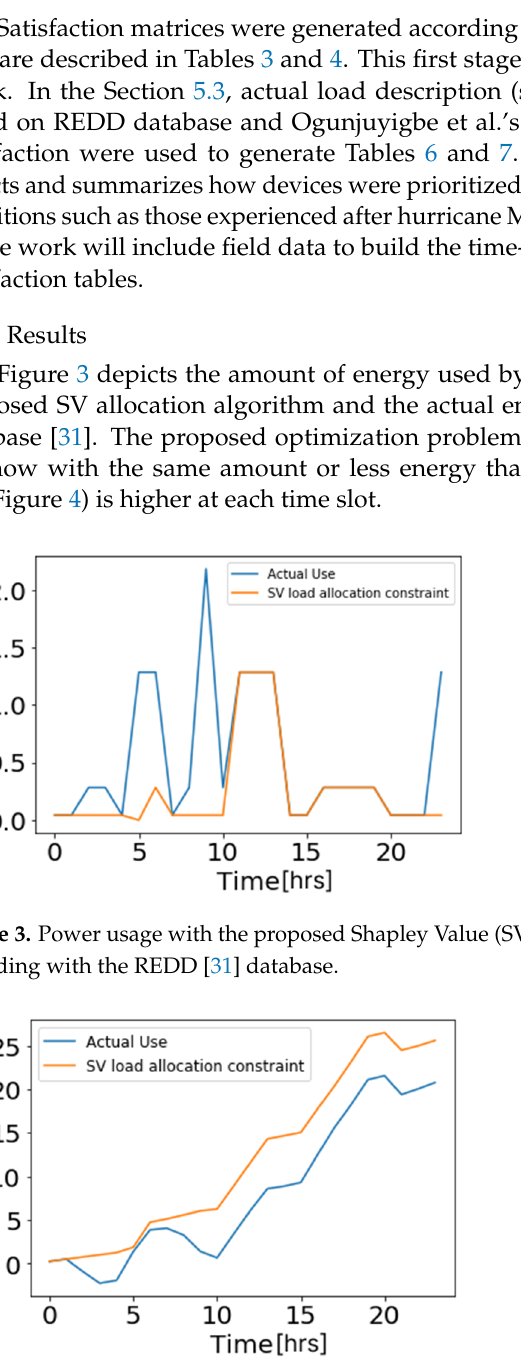
Table 3. Time-based satisfaction.